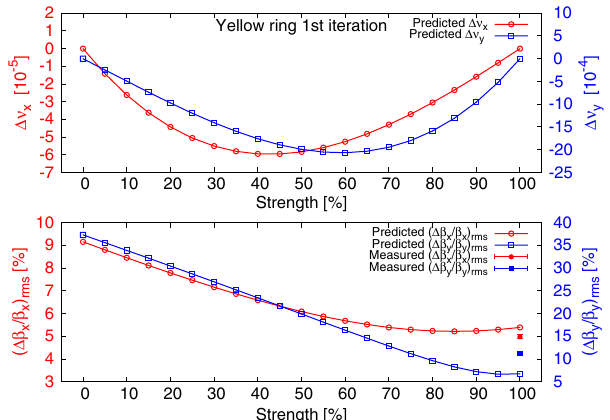
FIG. 8. Baseline and corrected vertical beta-beat with error bars for the Yellow ring. The peak beta-beat was reduced from 60% to 20% after the first iteration of correction, and further reduced to 10% after the second iteration.